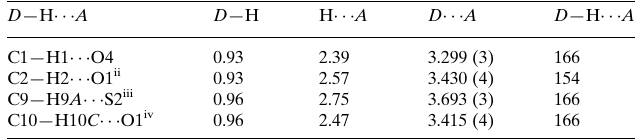
Hydrogen-bond geometry (A˚ , (cid:2)